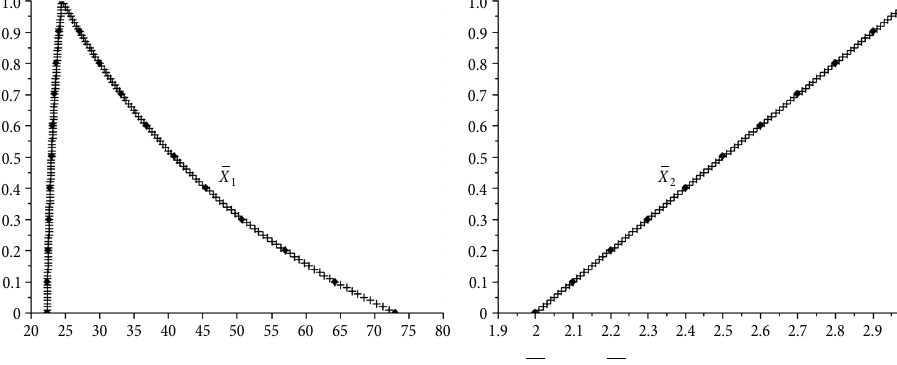
Fig. 4. The shapes of the maximal solutions 1 X and 2 X to Problem (10)